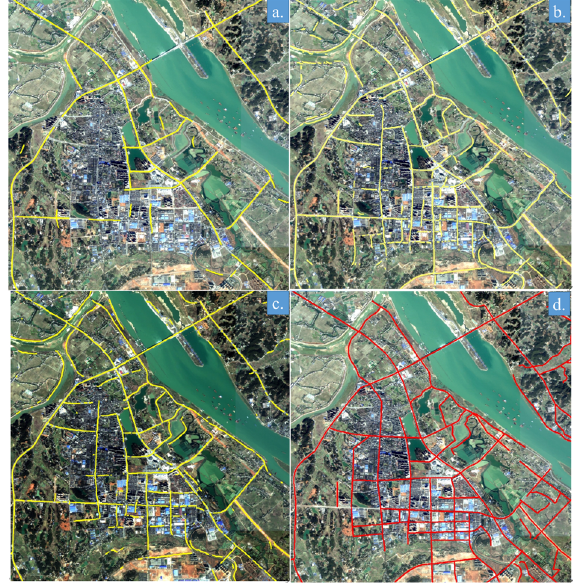
Figure 5. Part of interpreting result of road category. a.: result from Massachusetts Road dataset; b.: result from Massachusetts Road dataset + deep global; c: result from out dataset; d: